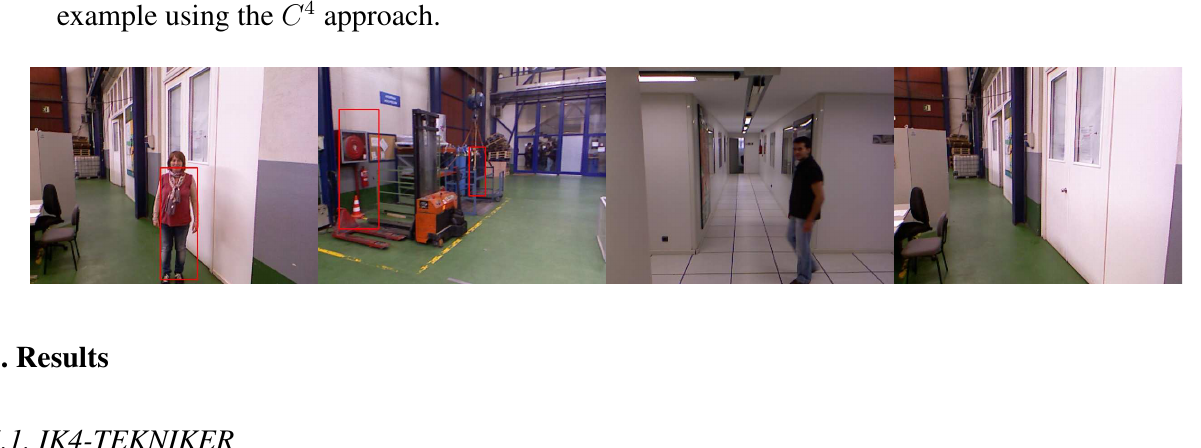
Figure 12. Respectively, a true positive, false positive, false negative and true negative example using the C 4